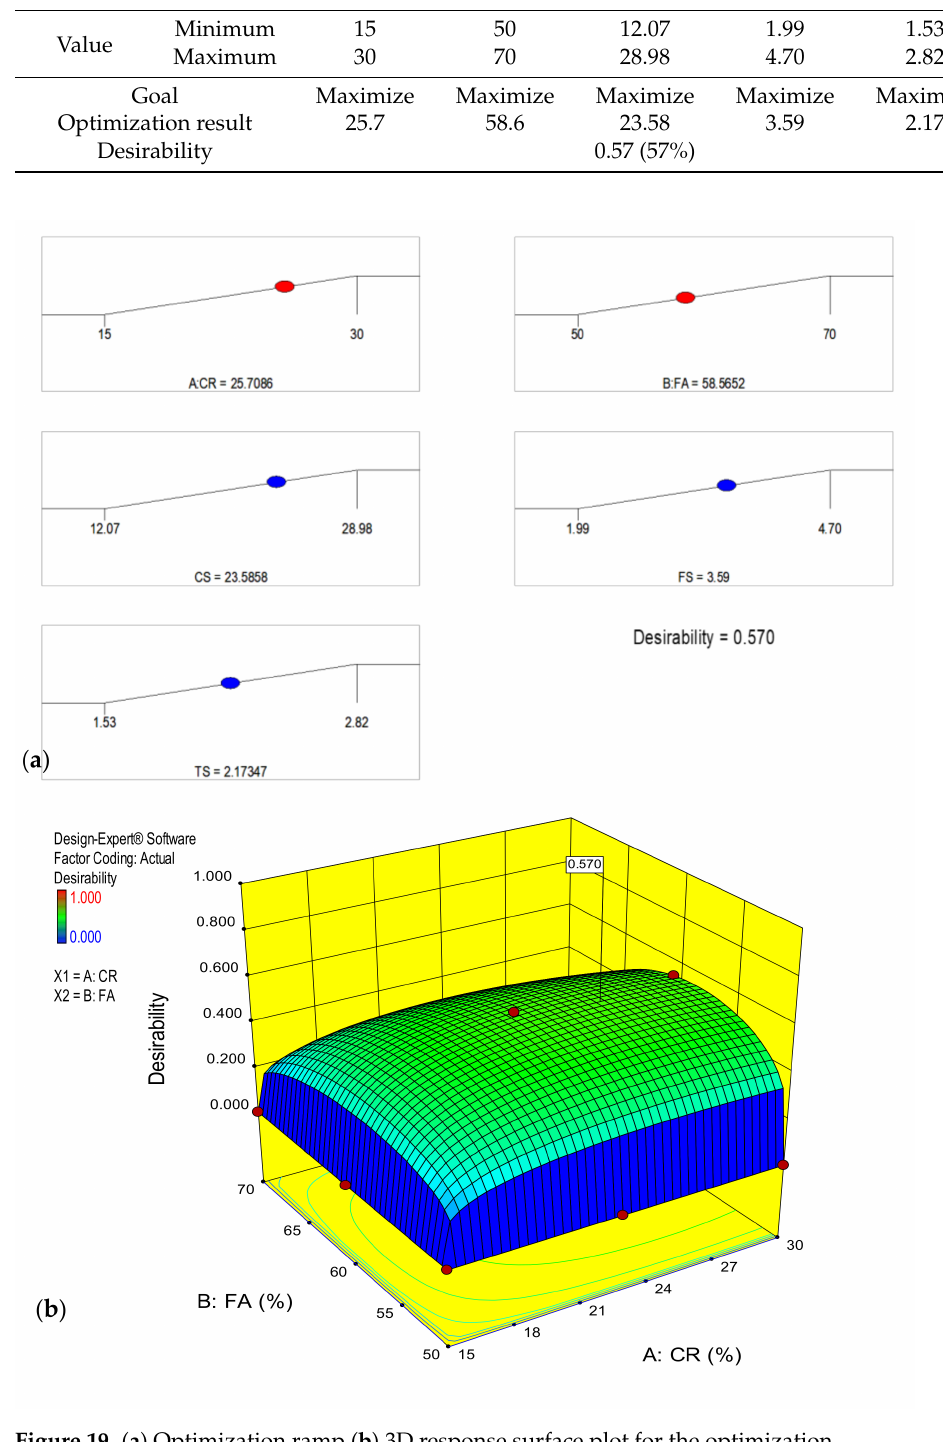
Figure 19. ( a ) Optimization ramp ( b ) 3D response surface plot for the optimization. The optimization result was experimentally validated by producing HVFA–CRC samples using the RSM-generated CR and HVFA replacements. Samples that were used to determine the CS, FS, and STS were cast, cured for 28 days, and tested. The averages of the results are shown in Table 7. The percentage error between the predicted and